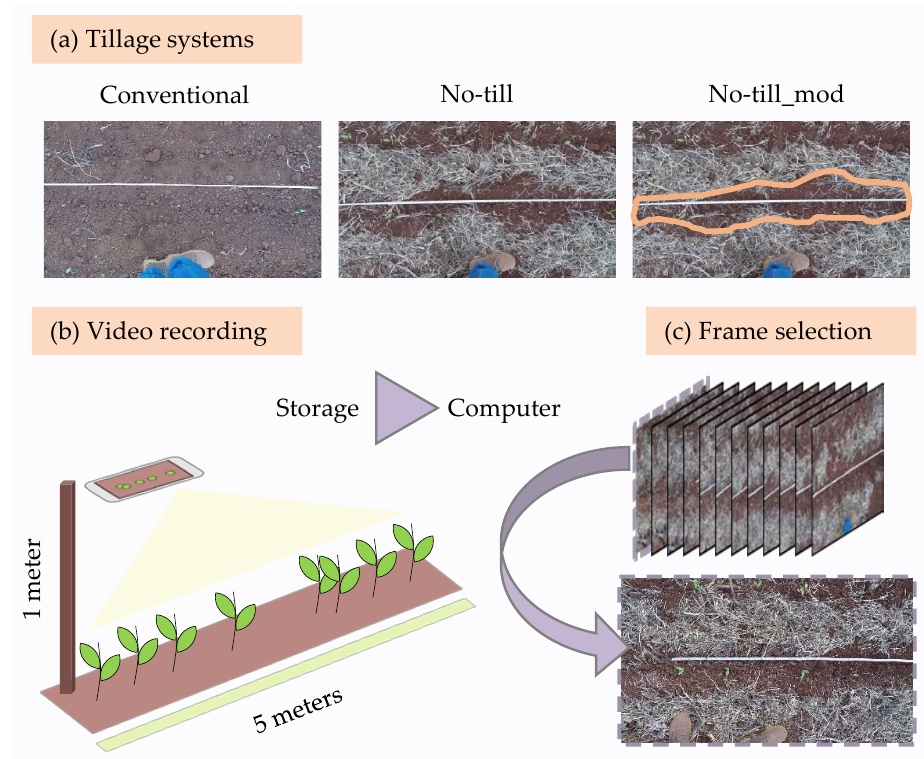
Figure 1. ( a ) Tillage systems used to create our dataset; ( b ) video recording technique and ( c ) manual frame selection